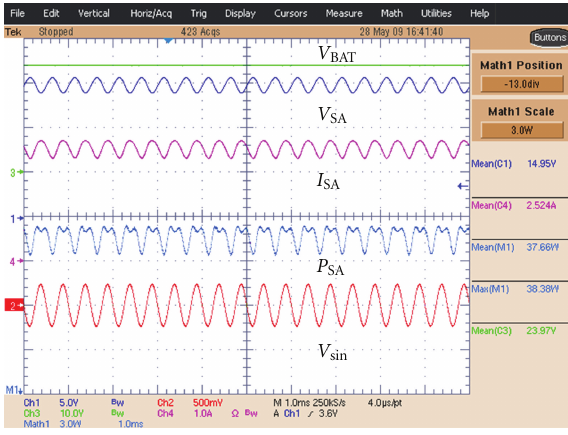
Figure 6: Steady-state